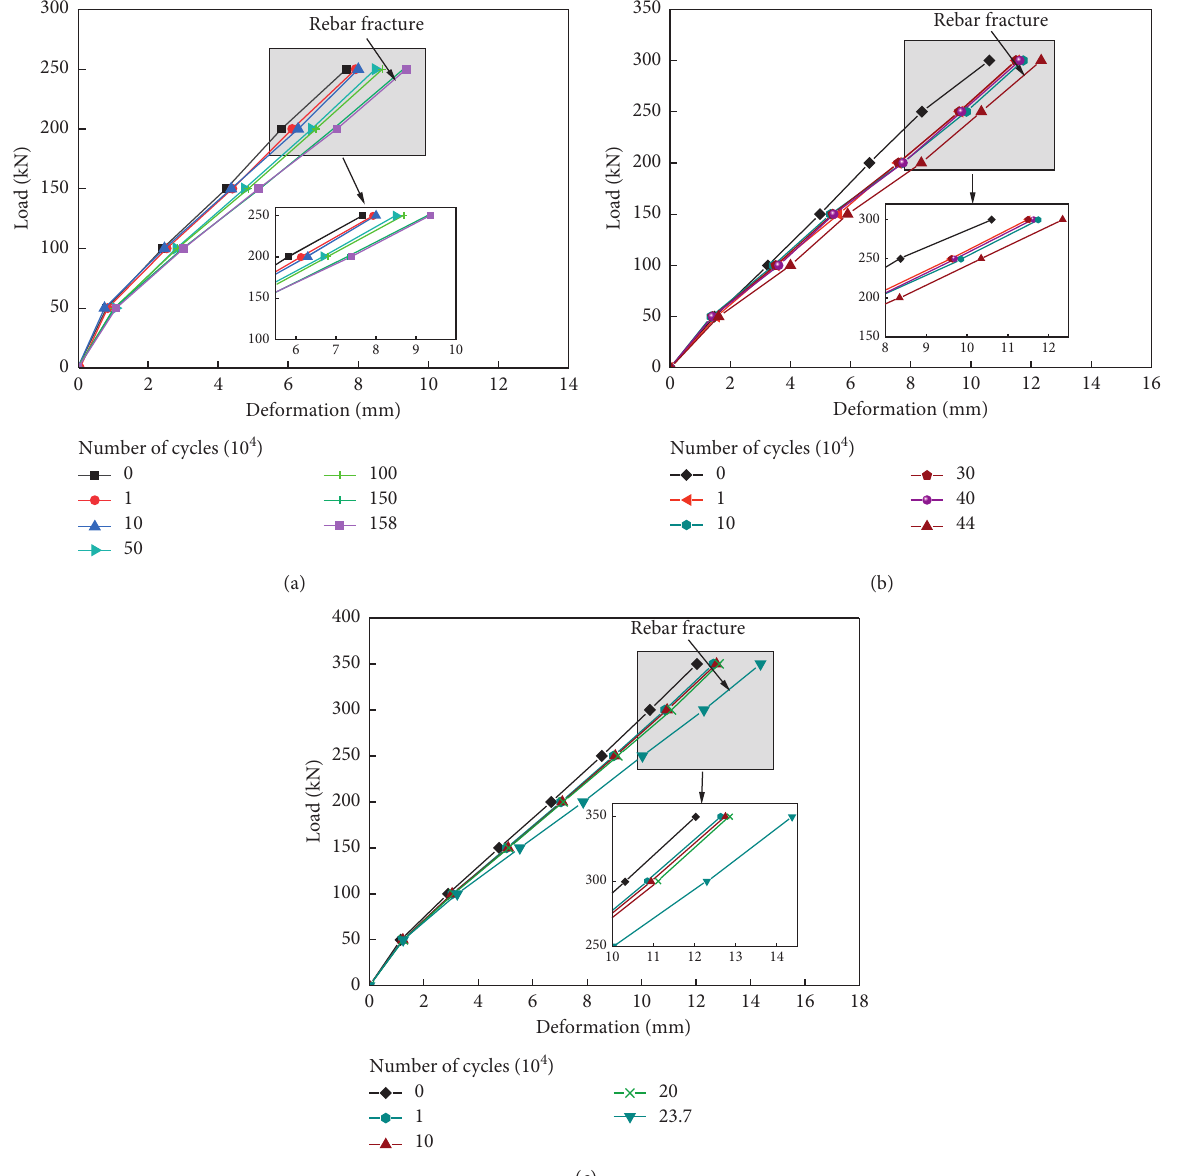
Figure 12: Load-midspan deflection in (a) JP1; (b) JP2; and (c)